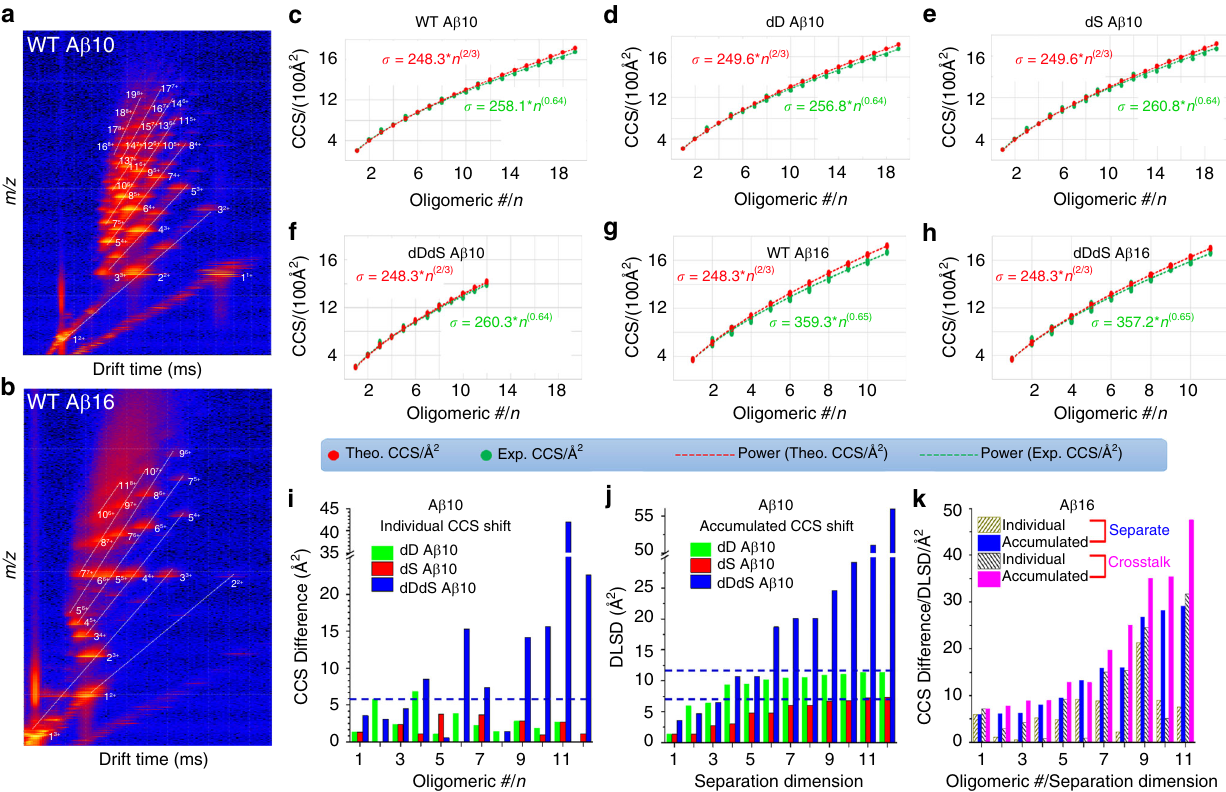
Fig. 4 iCAP for distinguishing chiral A β fragment oligomers. a , b Representative Driftscope maps for WT A β (1 – 10) and A β (1 – 16). c – h Growth curves for various A β fragments. For comparison, both isotropic growth-based prediction and IM-MS measurement-based experimental results have been shown. i CCS differences as a function of oligomeric number of A β (1 – 10) as calculated simply by deduction of CCS values from individual WT A β oligomers. j DLSD values as a function of separation dimension for accumulated A β (1 – 10) oligomers as calculated by accumulating the CCS differences in ( i ) using functions in Fig. 1. k Individual CCS differences (yellow and gray bars that are made of oblique lines) as a function of oligomeric number of A β (1 – 16) and accumulated DLSD values (blue and magenta bars) as a function of separation dimension for separate (WT and dDdS peptides were separately analyzed) and crosstalked (mixing WT and dDdS peptides) A β (1 – 16) oligomers. A β (1 – 10) and A β (1 – 16), 600 µ M. Buffer, 10 mM NH 4 OAc. Crosstalking experiments, fi nal concentrations of individual WT A β (1 – 16) and dDdS A β (1 – 16), 300 µ M. Source data are provided as a Source Data fi